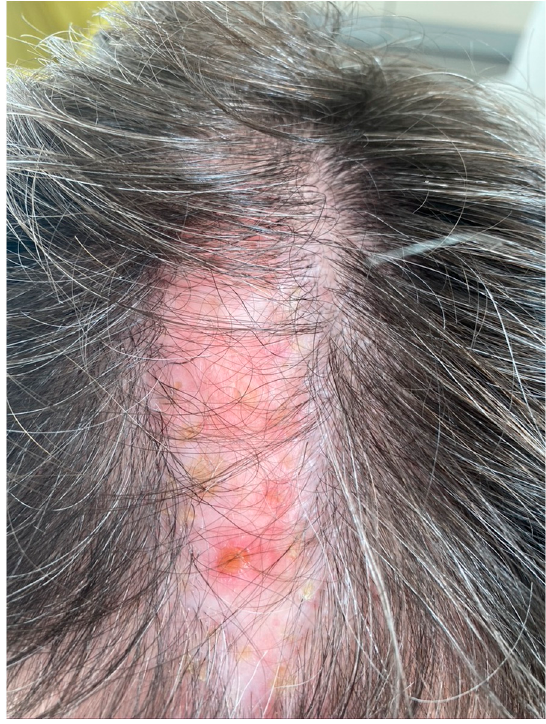
Figure 2. Lichen planopilaris of the scalp.